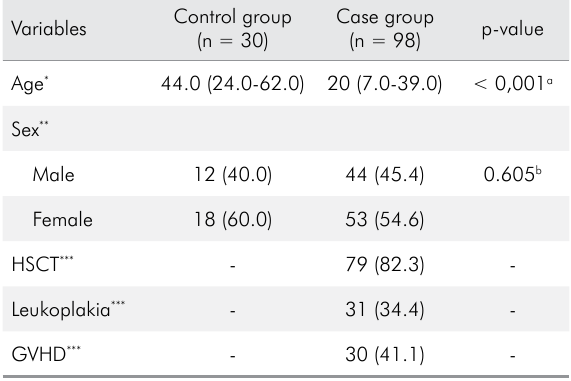
Table 1. Sociodemographic and clinical characteristics of the study